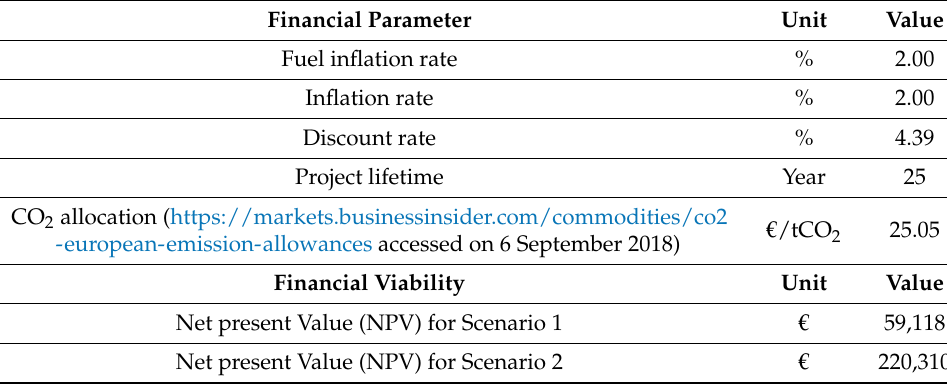
Table 6. Financial parameters used for assessment in Scenario 1 and